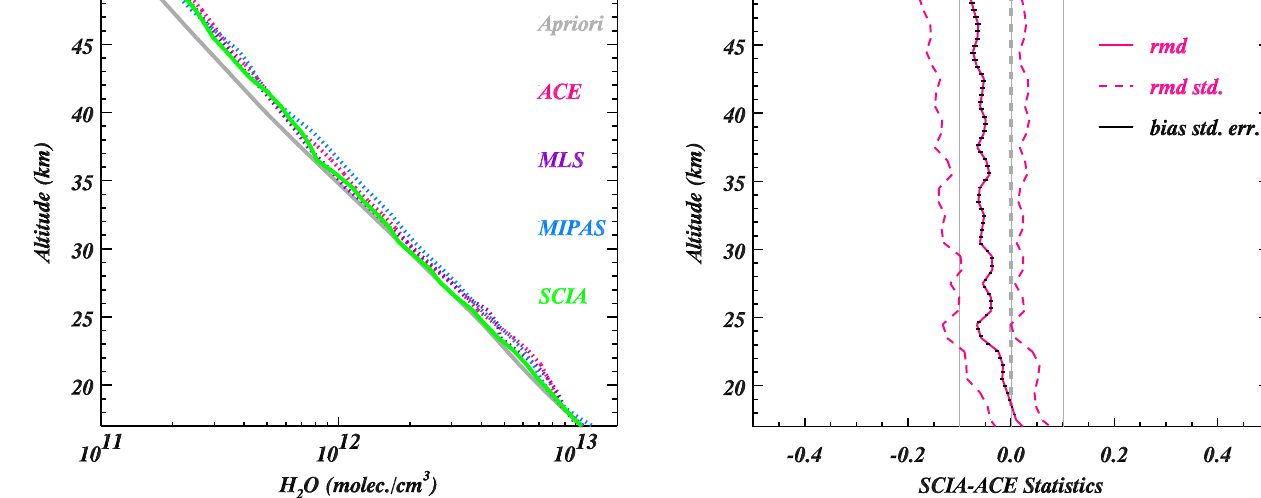
Fig. 12. An example of the retrieved SCIAMACHY lunar oc- cultation water vapor profile from 10 January 2009, orbit num- ber 35889. For this measurement three collocations are found with ACE-FTS(ss29145), MLS(T505691134), MIPAS(35894).